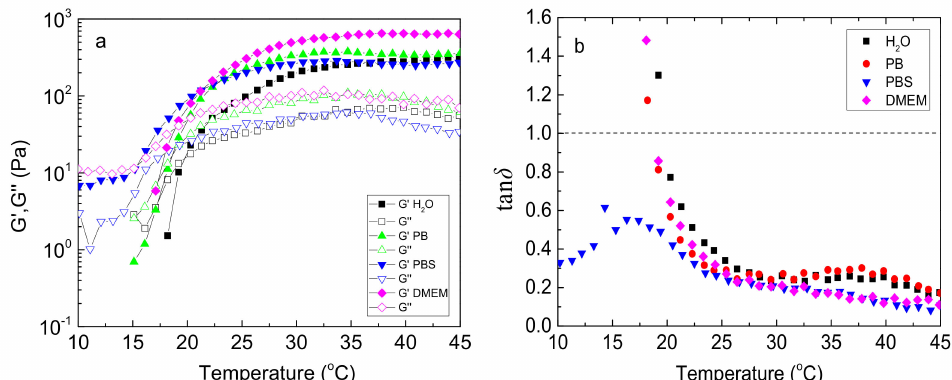
Figure 8. Temperature dependence of G’ (closed), G” (open) ( a ) and tan δ ( b ) (at 1 Hz, γ = 0.1%, heating rate 1 ◦ C/min) for 5 wt % NaALG- g -P(NIPAM 80 - co -NtBAM 20 ) graft copolymer in various media: water, phosphate buffer (PB), phosphate- buffered saline (PBS), Dulbecco’s modified Eagle’s medium (DMEM) (indicated in the